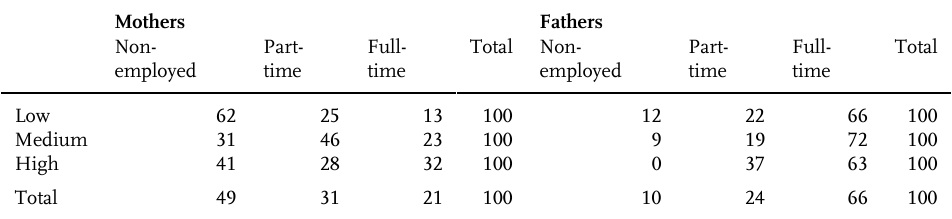
Table A6: Employment by level of education, April and May 2020, in % Mothers Fathers Non-